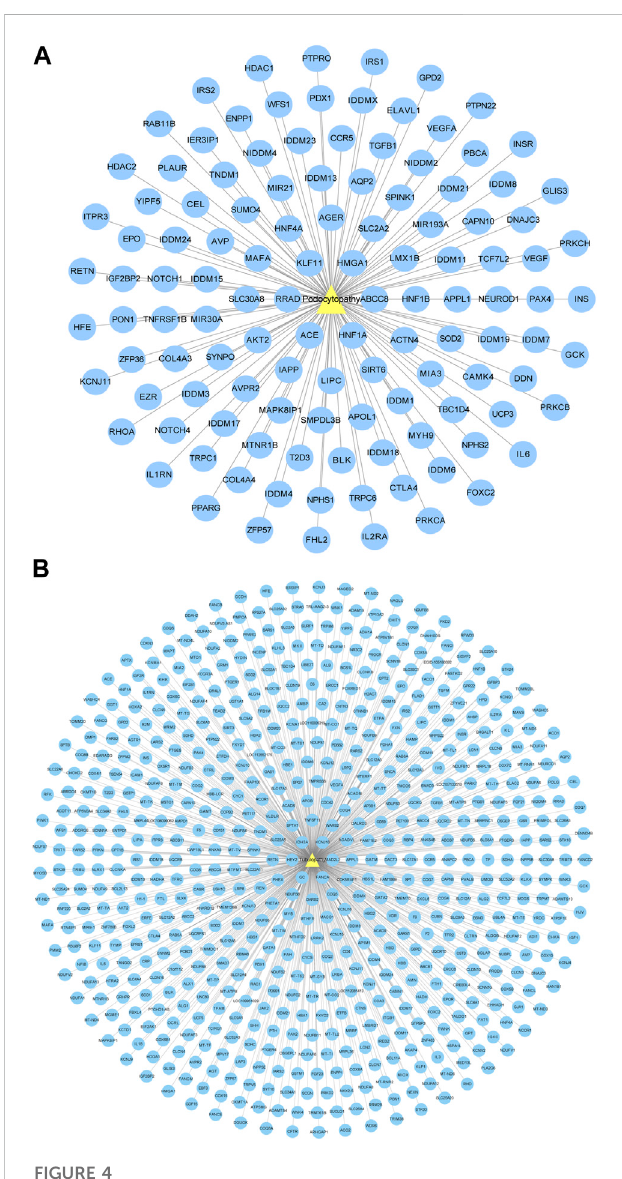
FIGURE 4 Disease-target network. (A) Diabetic podocytopathy-target network. Yellow triangle node represents diabetic podocytopathy and blue circular nodes represent corresponding targets. A total of 120 proteins were documented as the potential targets of diabetic podocytopathy. (B) Diabetic tubulopathy-target network. Yellow triangle node represents diabetic tubulopathy and blue circular nodes represent corresponding targets. Total 633 predicted target proteins of diabetic tubulopathy were identi fi